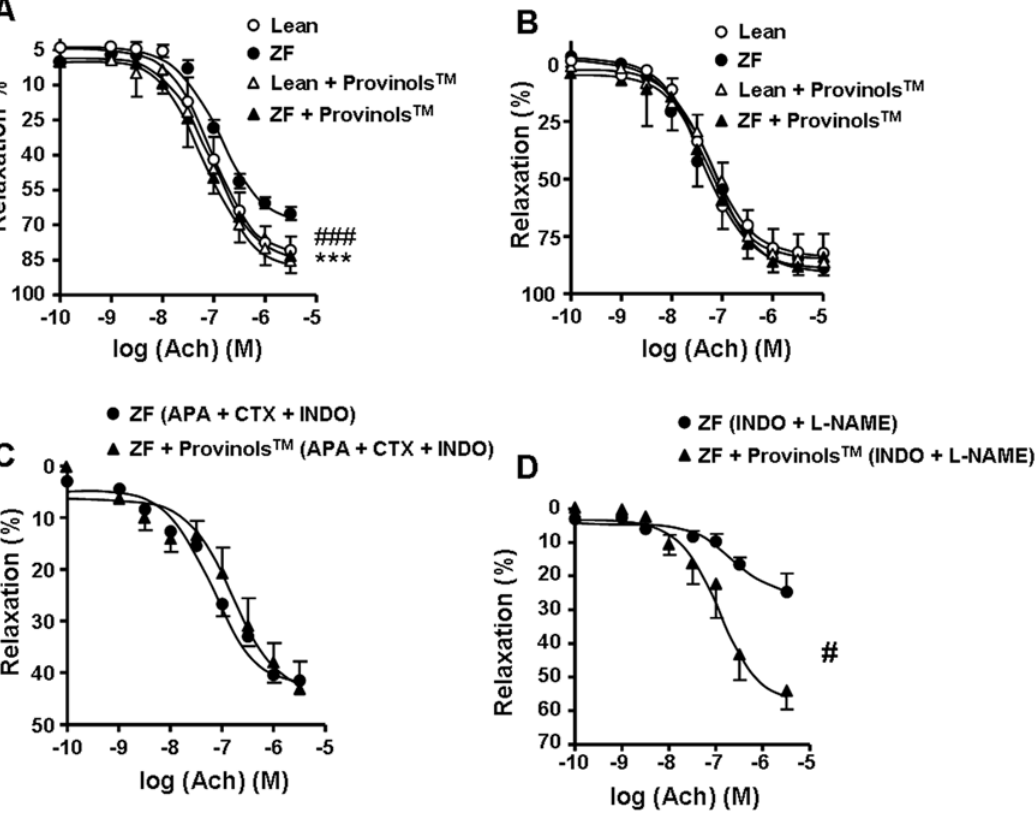
Figure 3. Provinols TM improve endothelial function in ZF rats. Acetylcholine (Ach)-induced relaxation in rat aorta (A), small mesenteric arteries (SMA) (B), SMA in the presence of inhibitors of EDHF and COX components (C) (apamine, APA; charybdotoxin, CTX; indomethacin, INDO), SMA in the presence of inhibitors of NO and COX components (D) (INDO, L-NAME). Results are expressed as a percentage of relaxation. Values are means 6 SEM ( n =6). * P , 0.05, *** P , 0.001 Zucker fatty (ZF) rats vs. lean rats; # P , 0.05, ### P , 0.001 ZF + Provinols TM rats vs. ZF